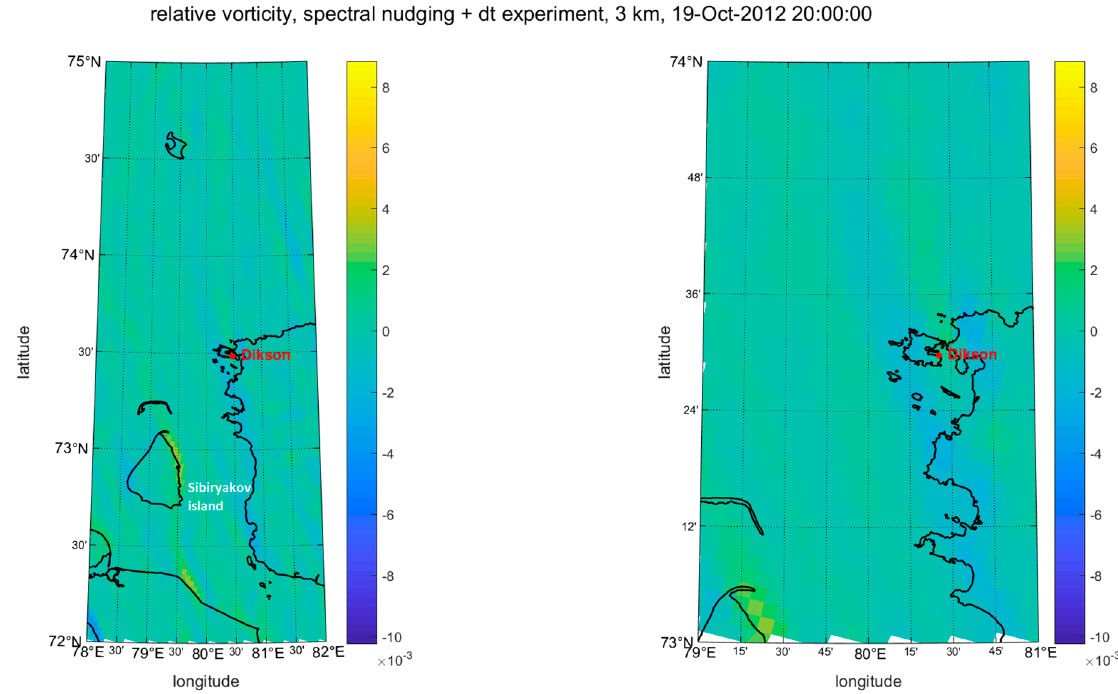
Figure 8. The same as in Figure 6, for the Dikson Island station region, on 19 October 2012, at 20:00 GMT.